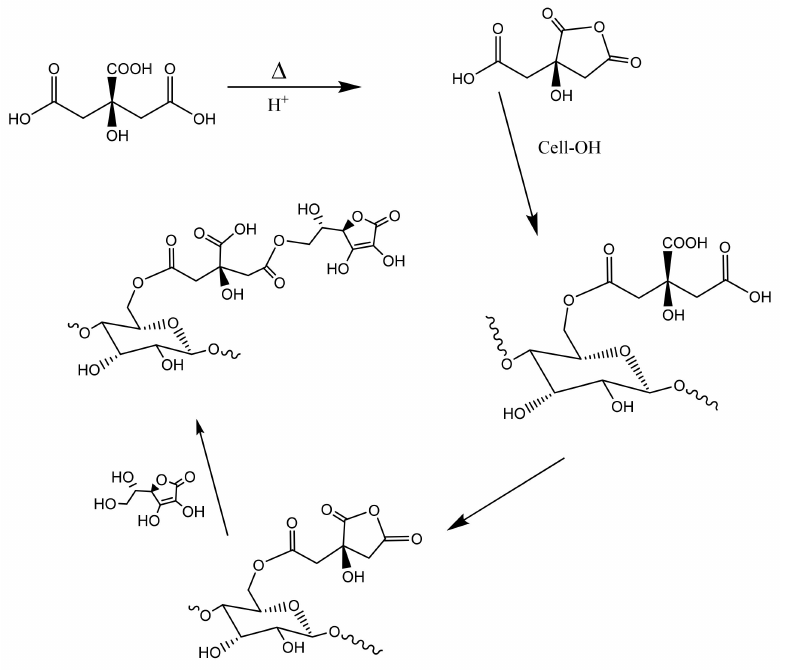
Figure 4. Schematic of the crosslinking reaction of ascorbic acid linked to cellulose. Ascorbic acid ((R)-5-[(S)-1,2,-dihydroxyethyl]-3,4-dihydroxyfuran-2(5H)-one) is reacted with citric acid under conventional pad-dry-cure conditions. The reaction is shown at the 1-hydroxy position of ascorbic acid to form the ester crosslinked analog of cellulose.